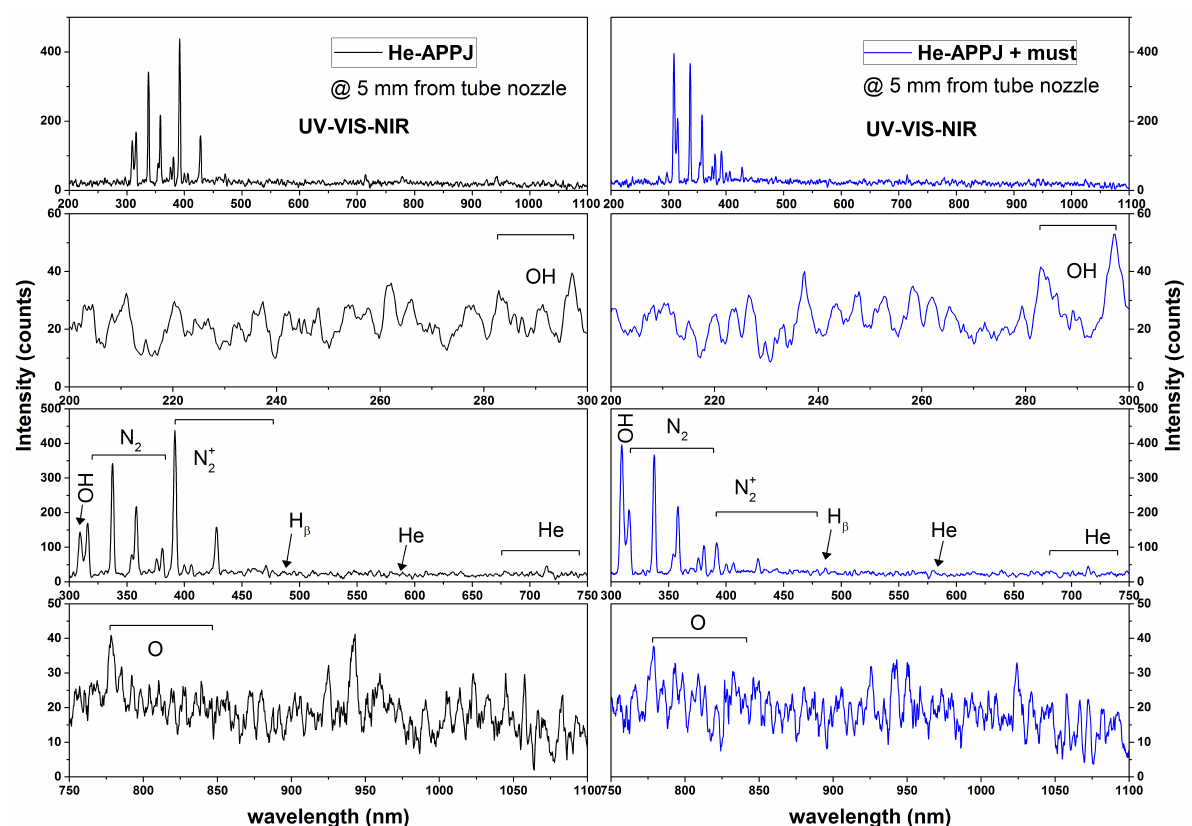
Figure 3. The emission spectra of the He-appj in mid air ( left side ) and interacting with the white must ( right side